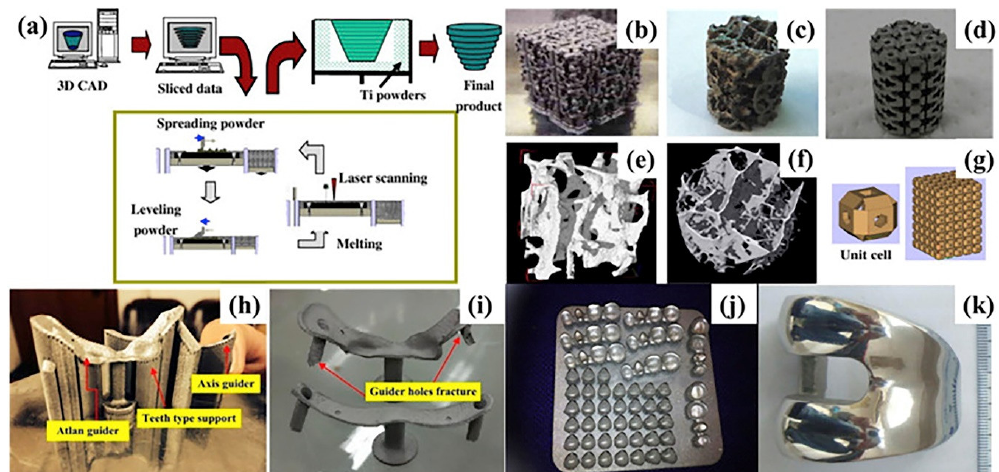
Figure 2. ( a ) Schematics of a laser beam melting (LBM) machine; ( b – d ) porous structures; ( e – f )